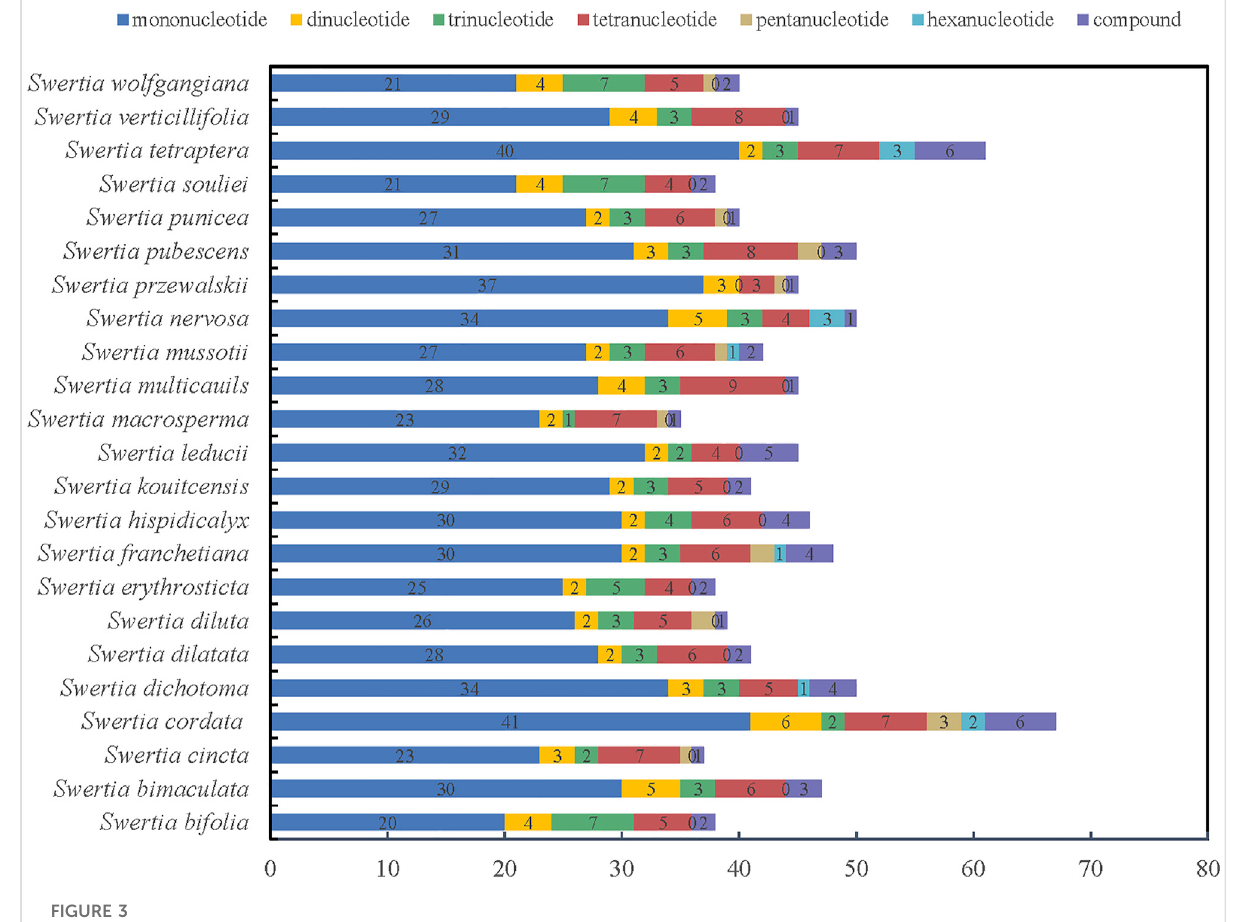
FIGURE 3 Simple sequence repeats (SSRs) in the 23 Swertia L. plastid